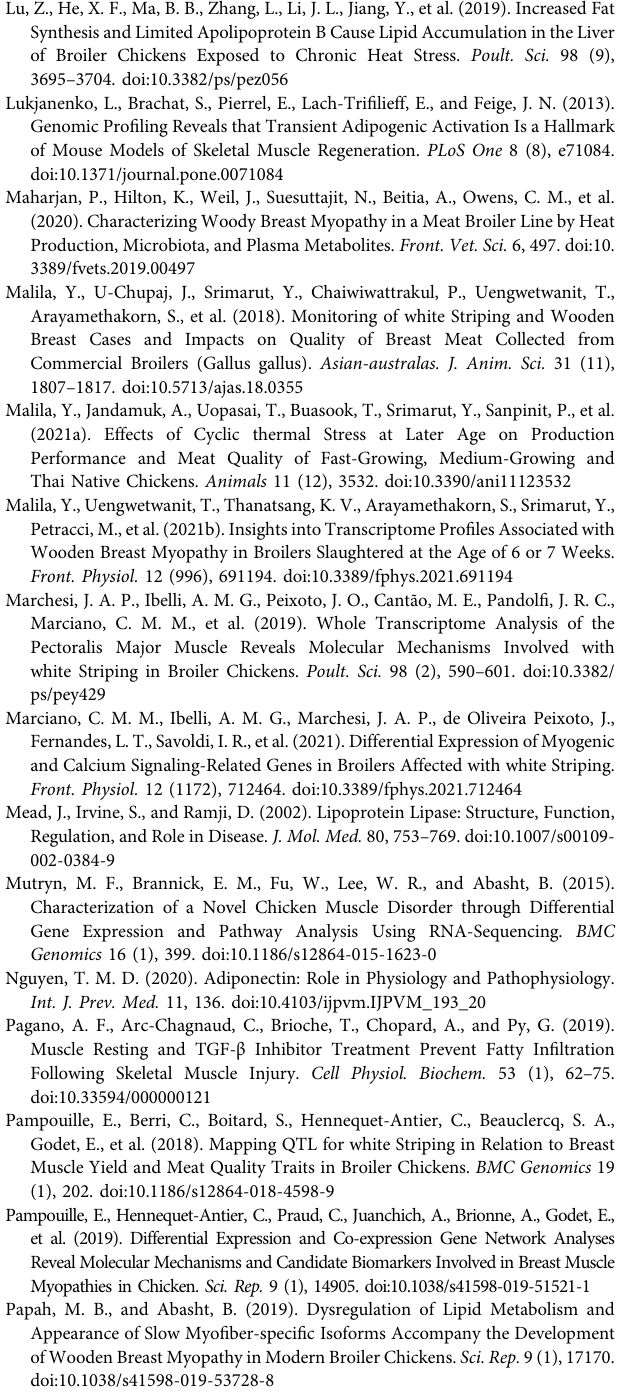
PLIN1 Promoter Downregulates Expression in Chicken Lines. Arch. Anim. Breed. 62 (2), 375 – 382. doi:10.5194/aab-62-375-2019 Tabler, T. W., Greene, E. S., Orlowski, S. K., Hiltz, J. Z., Anthony, N. B., and Dridi, S. (2020). Intestinal Barrier Integrity in Heat-Stressed Modern Broilers and Their Ancestor Wild Jungle Fowl. Front. Vet. Sci. 7 (249), 249. doi:10.3389/ fvets.2020.00249 Thanatsang, K. V., Malila, Y., Arayamethakorn, S., Srimarut, Y., Tatiyaborworntham, N., Uengwetwanit, T., et al. (2020). Nutritional Properties and Oxidative Indices of Broiler Breast Meat Affected by Wooden Breast Abnormality. Animals 10 (12), 2272. doi:10.3390/ ani10122272 Tijare,V.V.,Yang,F.L.,Kuttappan,V.A.,Alvarado,C.Z.,Coon,C.N.,and Owens,C. M. (2016). Meat Quality of Broiler Breast Fillets with white Striping and Woody Breast Muscle Myopathies. Poult. Sci. 95, 2167 – 2173. doi:10.3382/ps/pew129 Tirawattanawanich, C., Chantakru, S., Nimitsantiwong, W., and Tongyai, S. (2011). The Effects of Tropical Environmental Conditions on the Stress and Immune Responses of Commercial Broilers, Thai Indigenous Chickens, and Crossbred Chickens. J. Appl. Poult. Res. 20, 409 – 420. doi:10.3382/japr.2010- 00190 Uezumi, A., Fukada, S.-i., Yamamoto, N., Takeda, S. i., and Tsuchida, K. (2010). Mesenchymal Progenitors Distinct from Satellite Cells Contribute to Ectopic Fat Cell Formation in Skeletal Muscle. Nat. Cel Biol. 12 (2), 143 – 152. doi:10. 1038/ncb2014 Velleman, S. G., and Clark, D. L. (2015). Histopathologic and Myogenic Gene Expression Changes Associated with Wooden Breast in Broiler Breast Muscles. Avian Dis. 59 (3), 410 – 418.